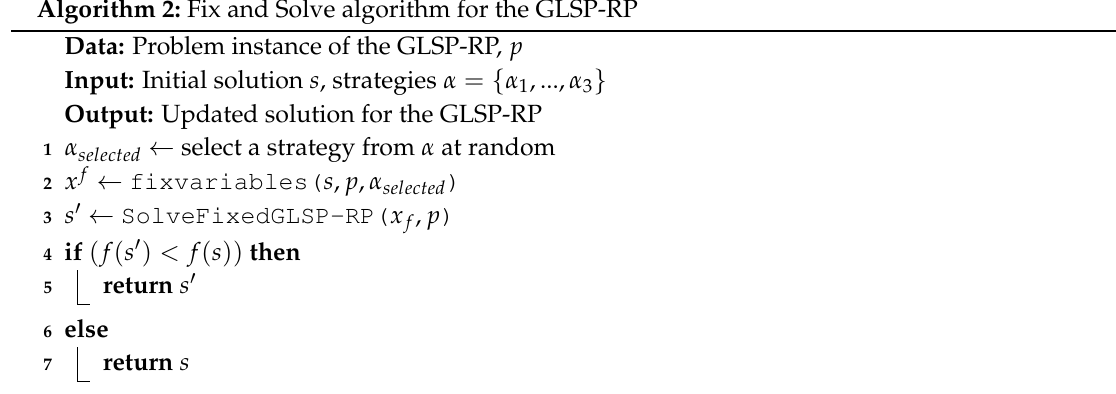
Algorithm 2: Fix and Solve algorithm for the GLSP-RP Data: Problem instance of the GLSP-RP, p